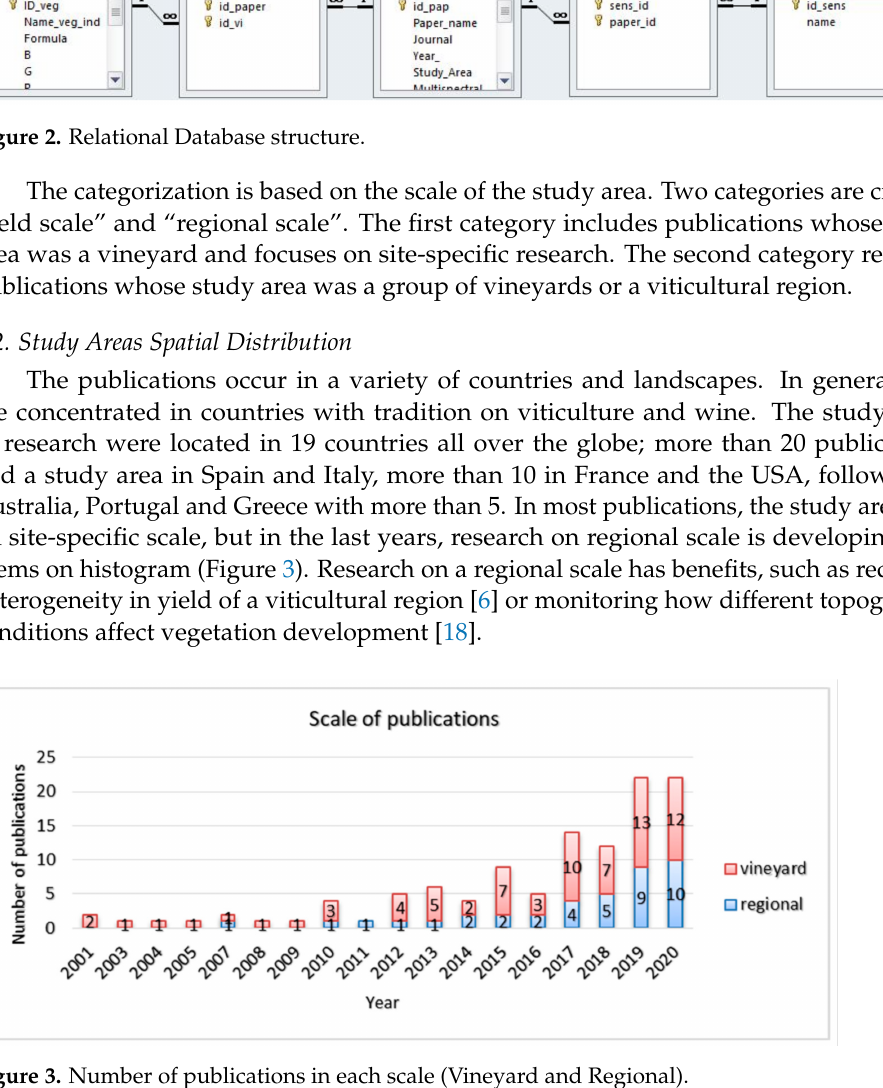
Figure 3. Number of publications in each scale (Vineyard and